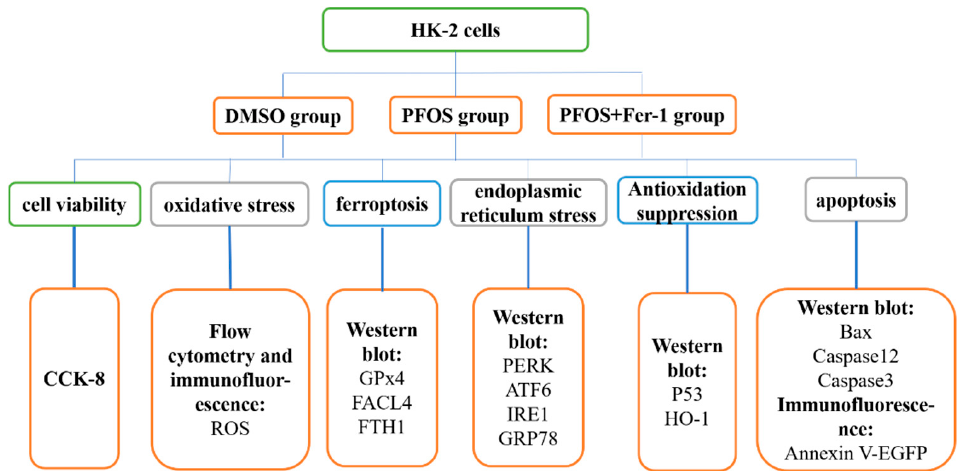
Figure 1. Schematic diagram of materials and methods.